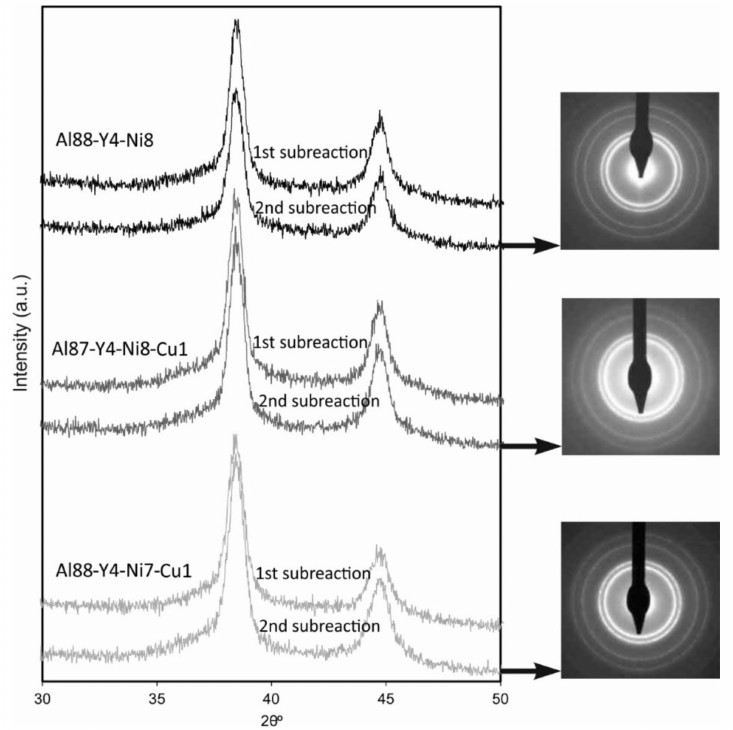
Figure 5. XRD patterns of heat treated ribbons up to the end of the two subreactions of the second DSC reaction, and the TEM DP of the Y-containing alloys at the end of the second DSC